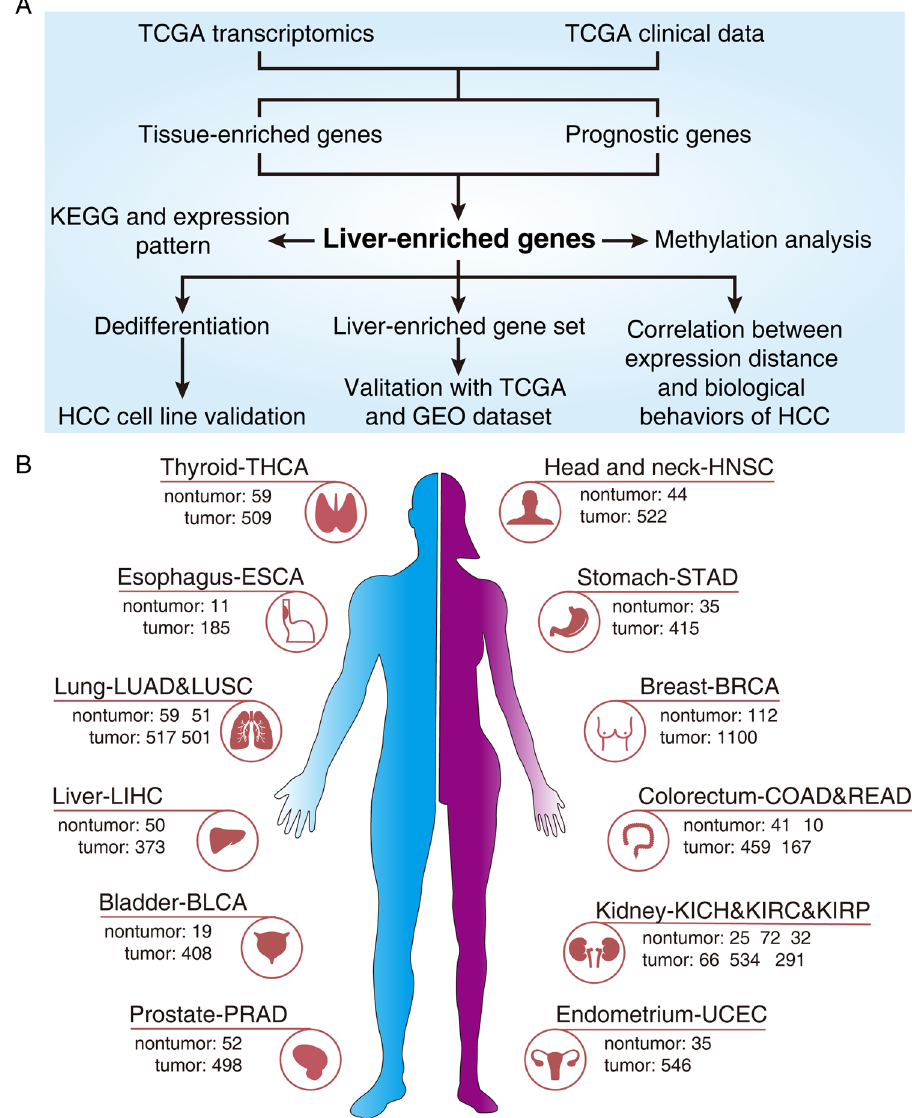
Cancer types with < 10 matching non-tumor samples were ruled out. As a result, 12 tissue types and 16 tumor types were selected, including 707 non-tumor samples and 7,091 tumor samples. Abbreviations: BLCA, bladder urothelial carcinoma. BRCA, breast invasive carcinoma. COAD, colon adenocarcinoma. ESCA, esophageal carcinoma. HNSC, head and neck squamous cell carcinoma. KICH, kidney chromophobe. KIRC, kidney renal clear cell carcinoma. KIRP, kidney renal papillary cell carcinoma. LIHC, liver hepatocellular carcinoma. LUAD, lung adenocarcinoma. LUSC, lung squamous cell carcinoma. PRAD, prostate adenocarcinoma. READ, rectum adenocarcinoma. STAD, stomach adenocarcinoma. THCA, thyroid carcinoma. UCEC, uterine corpus endometrial